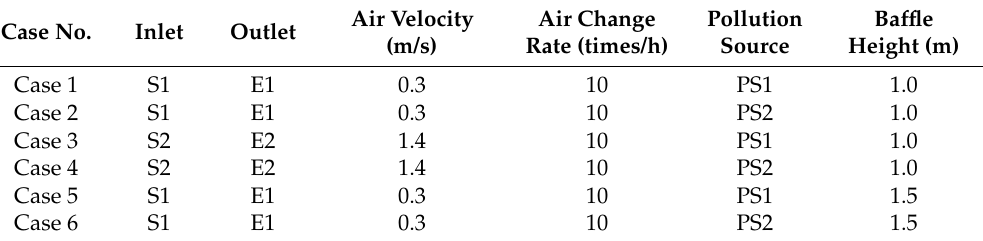
Table 3. Case setup (Model I).